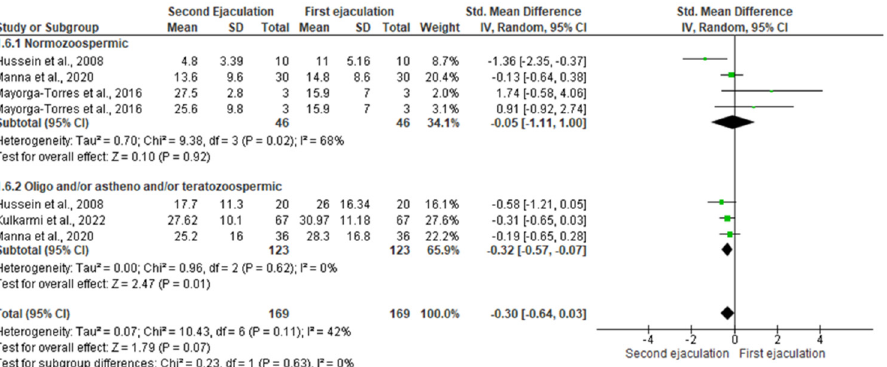
Figure 7. Forest plot of studies that evaluated the effects of a very short abstinence period on sperm DNA fragmentation (expressed as a percentage). The following studies were included in the quantitative analysis (in order of appearance in the manuscript): Manna et al., 2020 [16], Hussein et